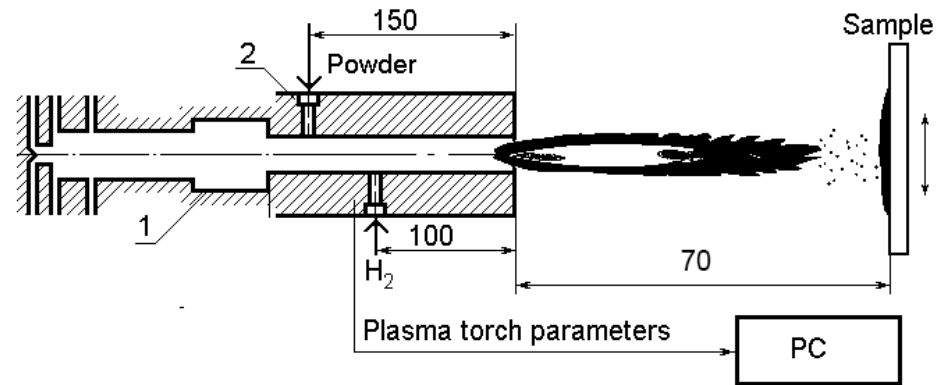
Figure 2. Schematic view of experimental setup: ( 1 ) plasma torch and ( 2 ) reactor.